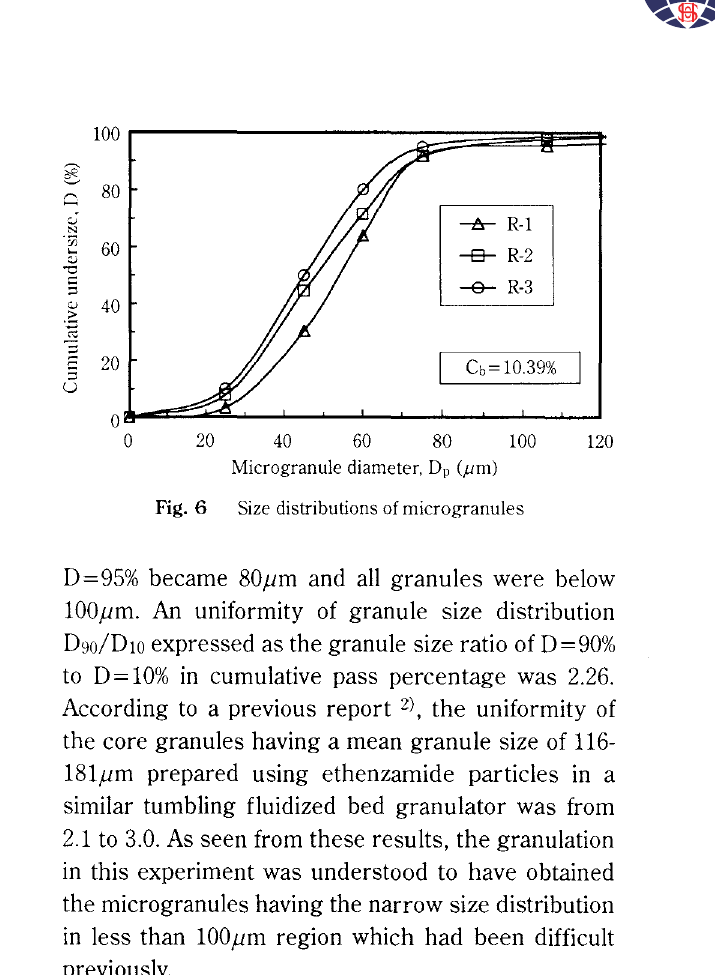
D=95% became 80,um and all granules were below 100,um. An uniformity of granule size distribution Dgo/DJO expressed as the granule size ratio of D=90% to D = 10% in cumulative pass percentage was